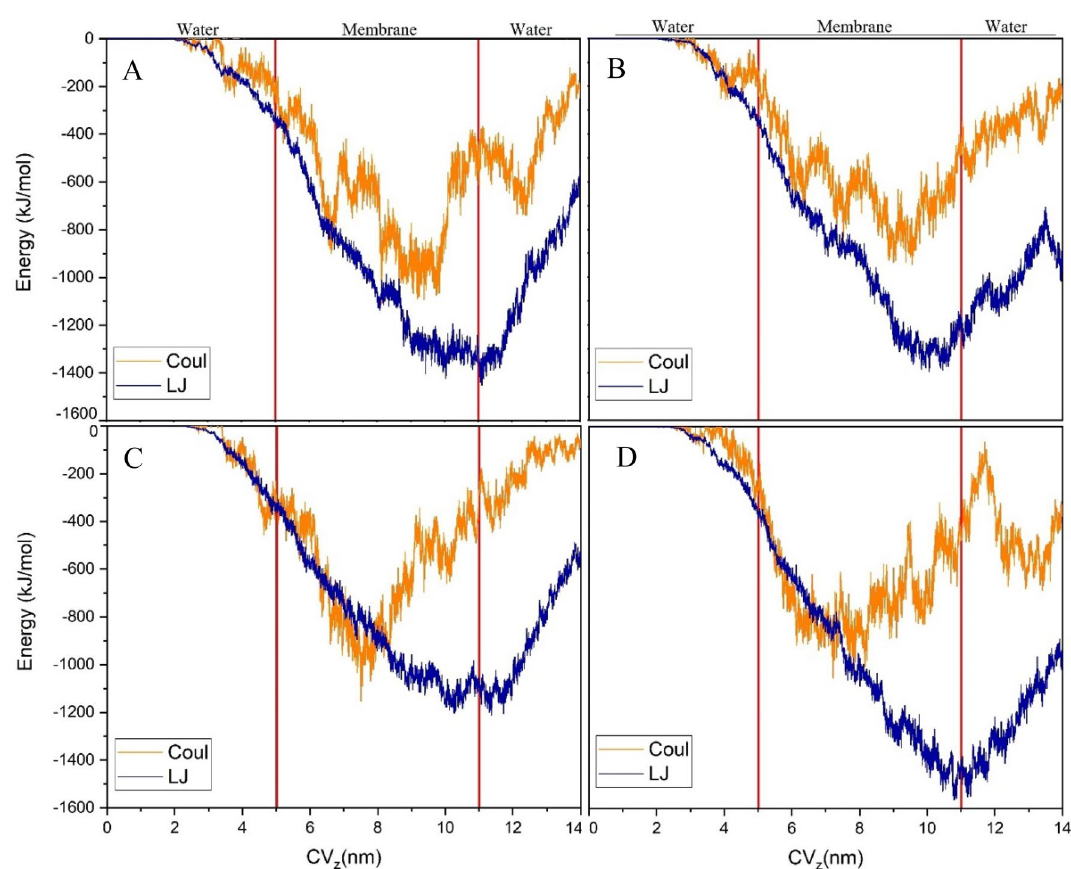
Figure 21. Variation of LJ and electrostatic (Coul) energies between phytosome and the membrane as a function of collective variable (CVz, the COM position of the phytosome in the z-direction) during SMD in ( A ) Eg-PC, ( B ) Lu-PC, ( C ) Qu-PC, and ( D )